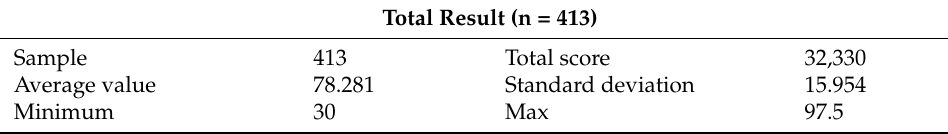
Table 5. Total system availability scale results.